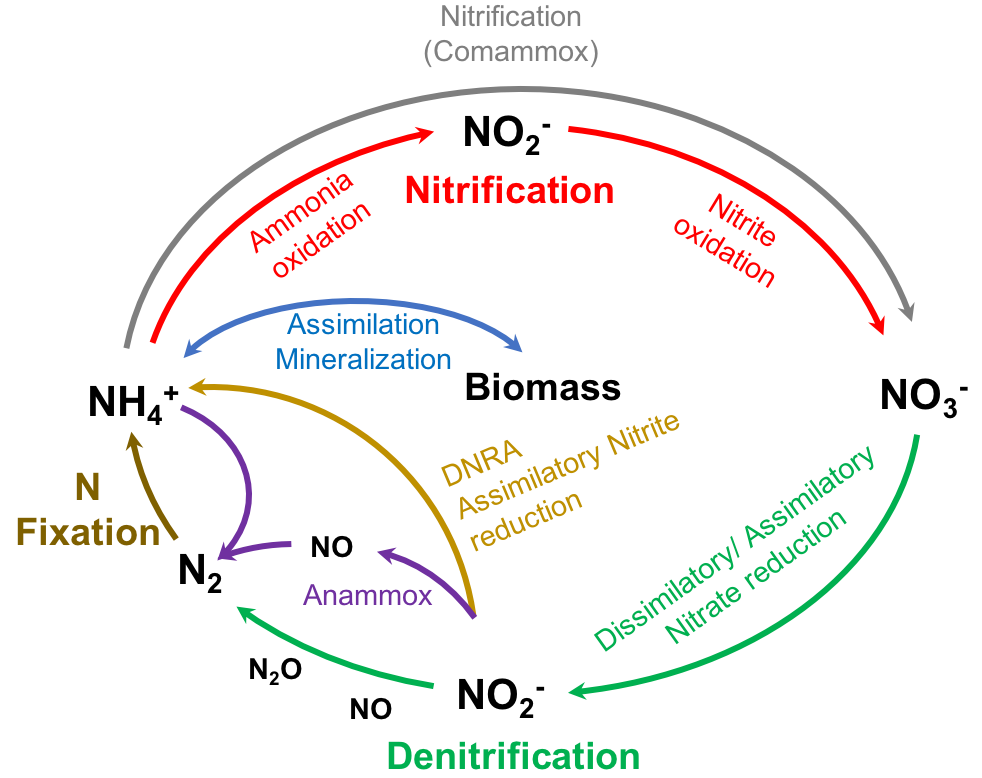
Figure 2. Biogeochemical cycle of nitrogen. Schematic illustration of the key processes of the nitrogen cycle (adapted from [45]).